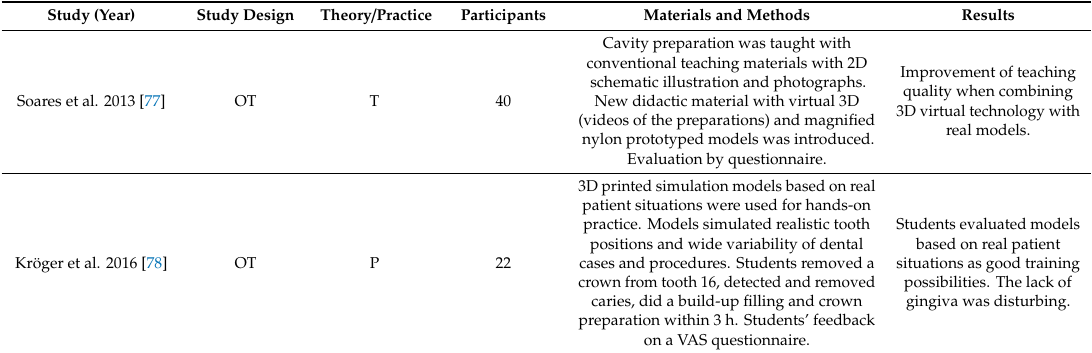
Table 4. Group 4: 3D printing and prototyping ( n = 2).